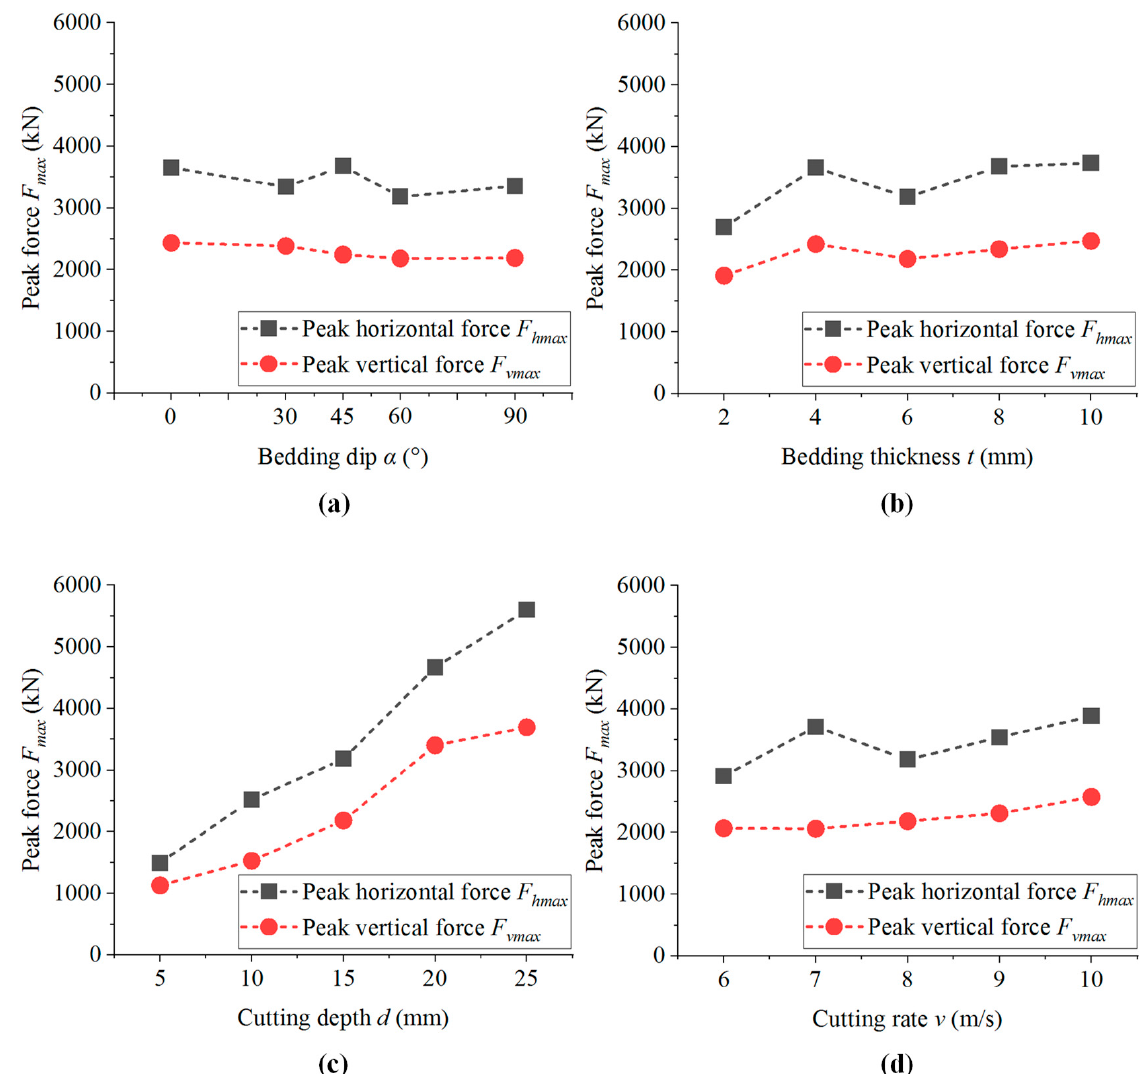
Figure 26. In the cutting process, the peak horizontal cutting force and the peak vertical cutting force of the sample change with different levels of various factors. ( a ) Effect of bedding dips on peak cutting force; ( b ) effect of bedding thicknesses on peak cutting force; ( c ) effect of cutting depths on peak cutting force; ( d ) effect of cutting rates on peak cutting force.